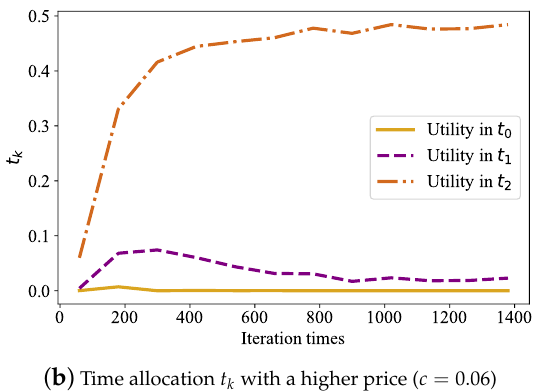
Figure 11. Time allocation with different prices to crowd